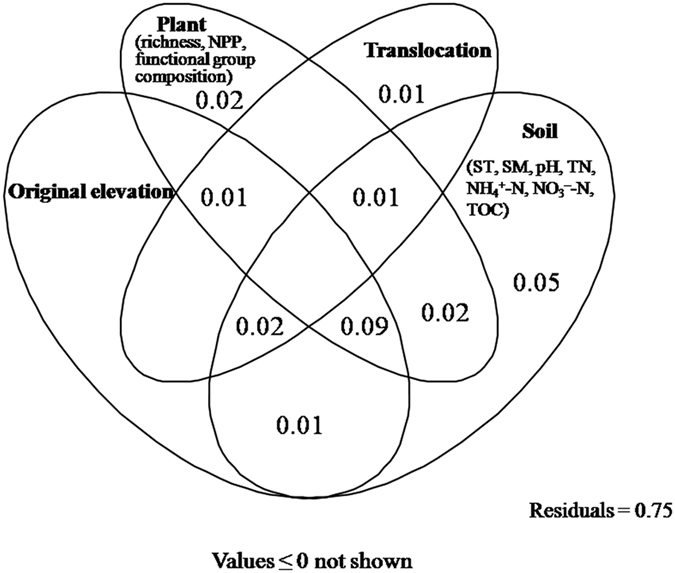
Variation partitioning analysis showing the effects of original elevation, translocation, soil and plant variables on arbuscular mycorrhizal fungal community.Numbers indicate the proportion of explained variation. Abbreviations: ST, soil temperature; SM, soil moisture; TN, soil total nitrogen; TOC; soil total organic carbon; richness, plant species richness; NPP, plant net primary production.